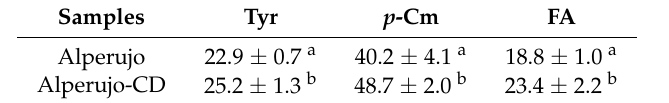
Table 1. Bioavailability of phenolic compounds in Caco-2 cells as percentage of their initial apical amount.